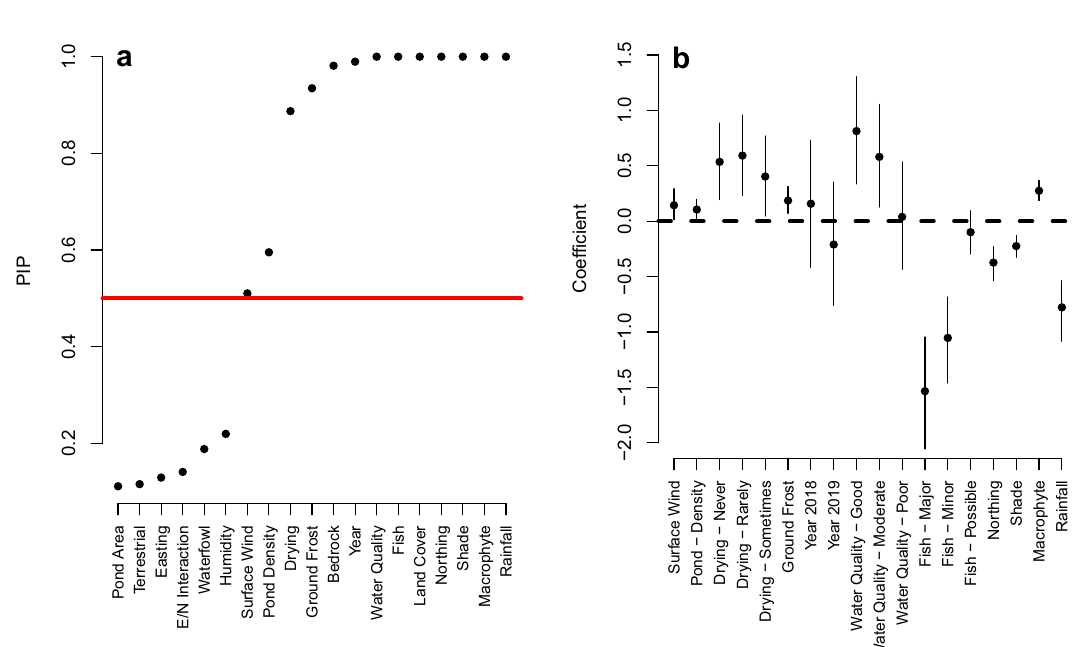
Figure 4. ( a ) PIP values for each covariate, those scoring above 0.5 (red line) were considered important predictors for great crested newt occupancy; and ( b ) occupancy coefficients and posterior credible intervals for each level for covariates, where PIP values were greater than 0.5. Land cover and geology have been omitted, for visual reasons, due to the large number of categories in each, these can be found in Table